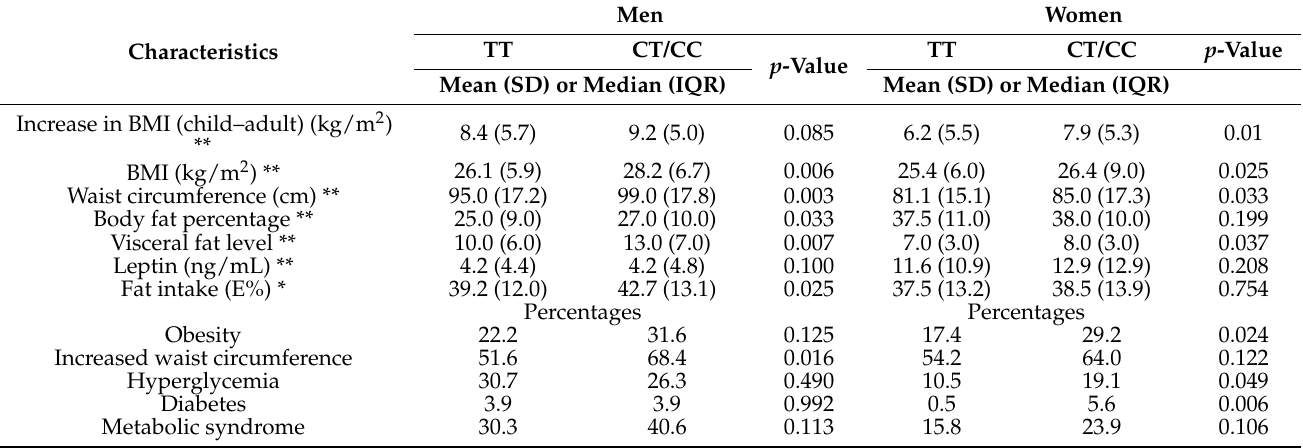
Table 4. Association of the MC4R rs17782313 polymorphism with anthropometric measurements and other factors in adulthood.